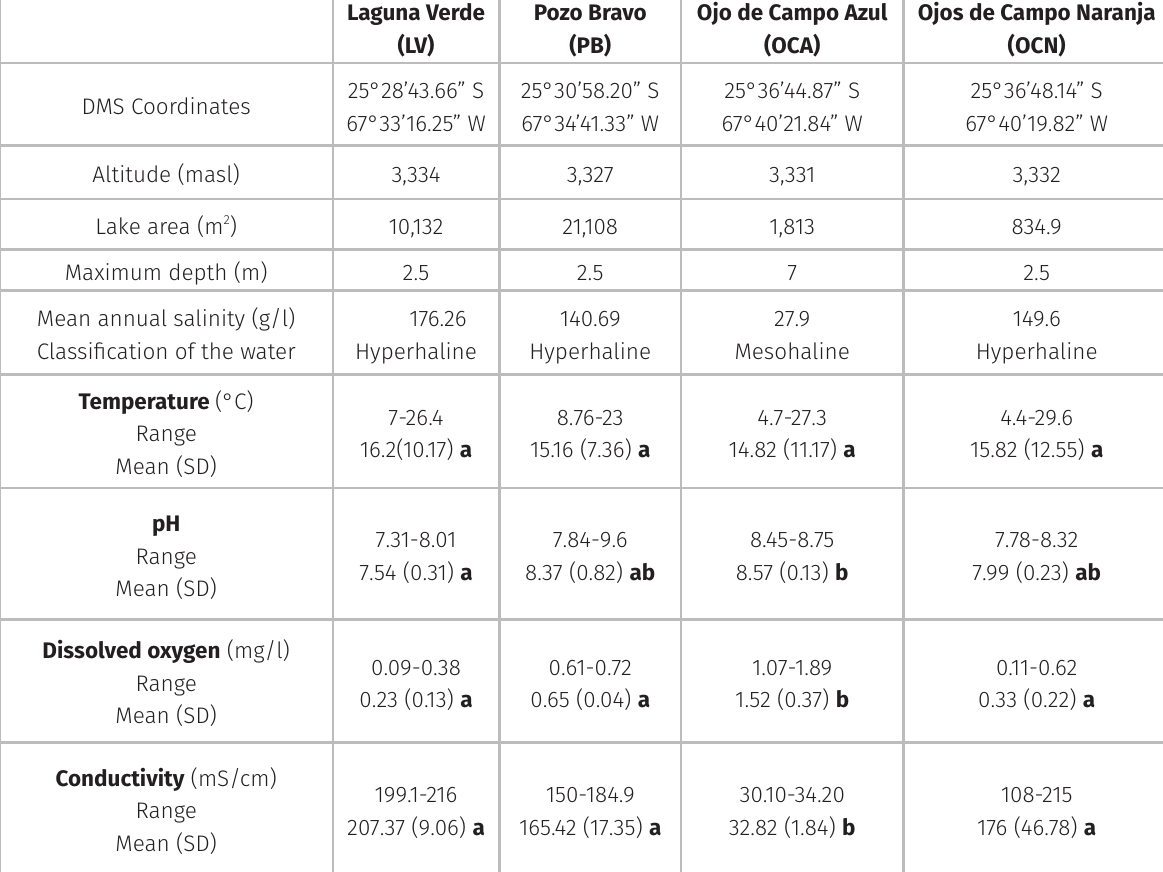
Table I. Geographical coordinates, morphological variables and aquatic parameters measured at each study site of the Salar de Antofalla, Catamarca. Classification of the wetlands according to salinity followed Hammer (1986). Range, mean and standard deviation (SD) of four seasonal aquatic variables are presented (n=4). Values with at least one letter in common did not differ statistically (ANOVA; Bonferroni post-hoc test; p